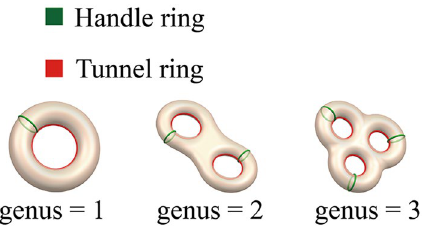
Figure 1. The genus corresponds to the number of handle and tunnel